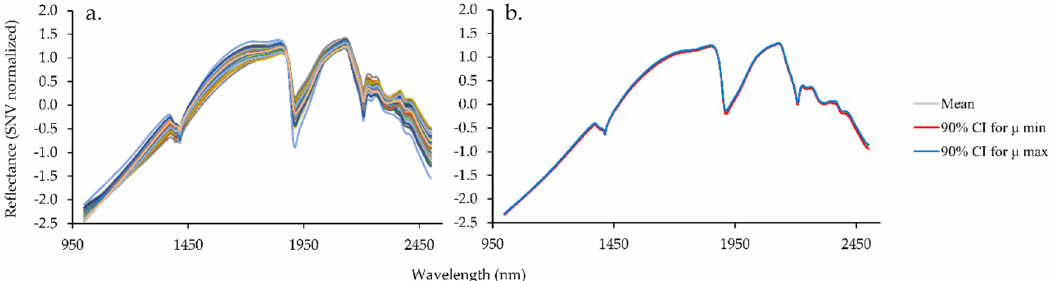
Figure 2. The raw spectral reflectance data of the soil samples of the studied site after normalization by the standard normal variate (SNV) method (n = 80). Each line represent one sample. ( a ) and the mean spectra with its 90% confidence interval ( b ).